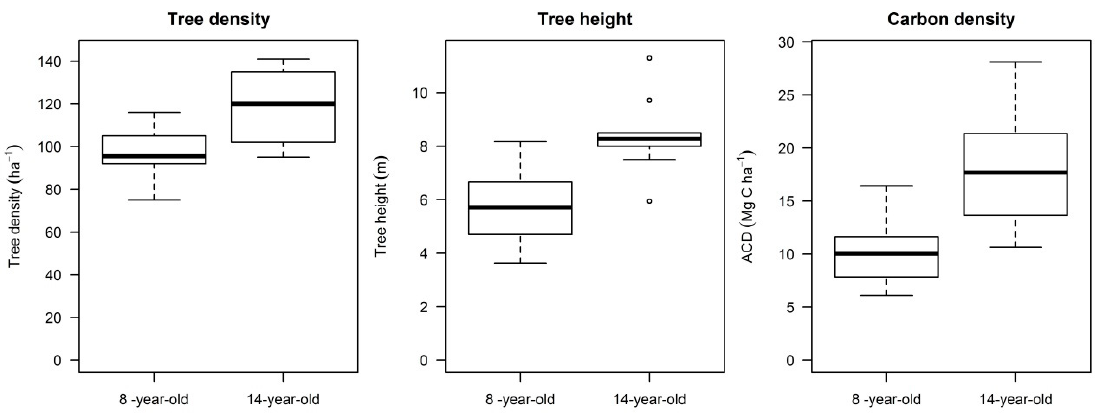
Figure 2. Boxplots contrasting the structural attributes of oil palm plantations of two different ages (x-axis), based on measurements taken in 27 1-ha plots. ACD is aboveground carbon density (Mg C ha − 1 ).